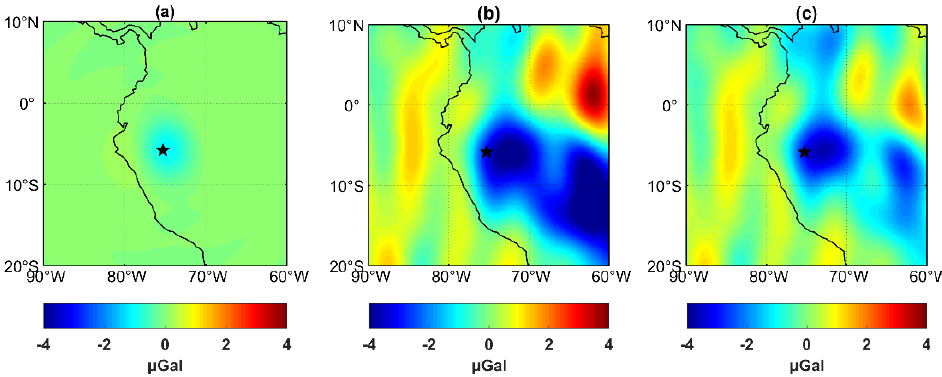
Figure 13. Coseismic gravity change in the 2019 Mw8.0 Peru earthquake region. ( a ) The dislocation model prediction by USGS fault slip model. ( b ) Coseismic gravity changes from GFO observations. ( c ) Coseismic gravity changes from GFO observations with hydrological signal removed by the GLDAS model.